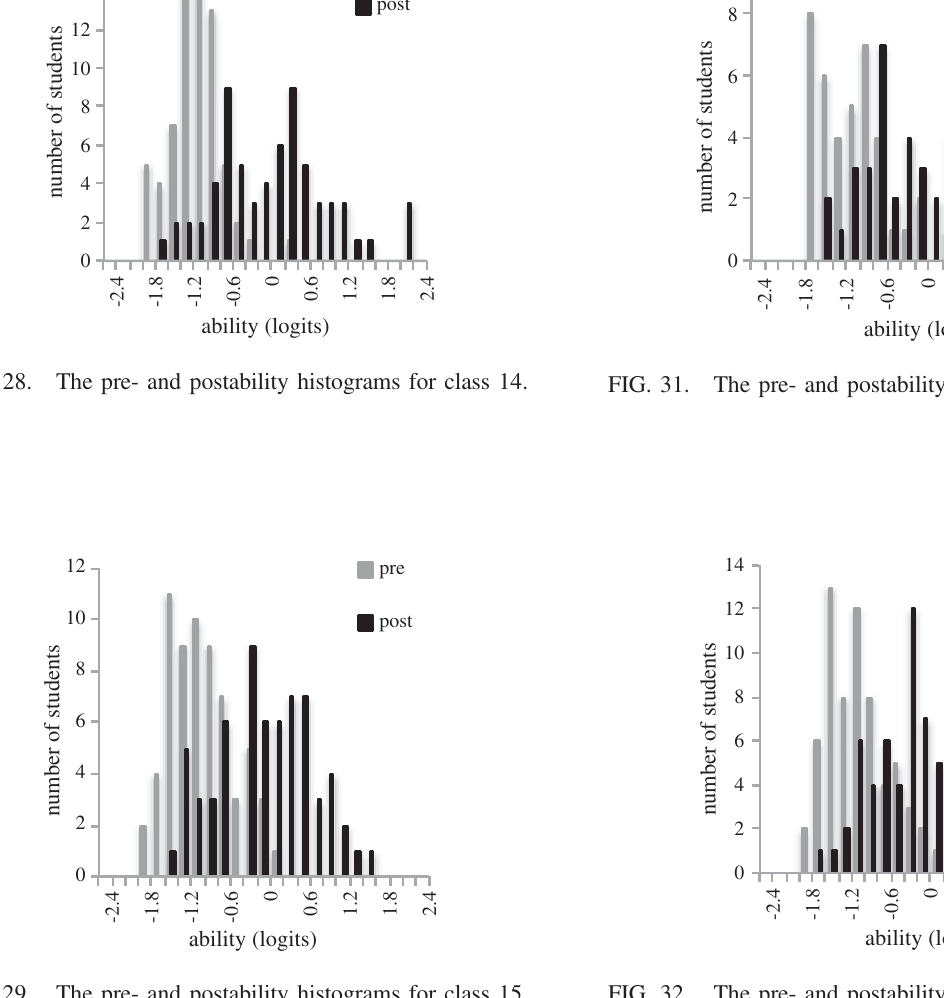
FIG. 29. The pre- and postability histograms for class 15.